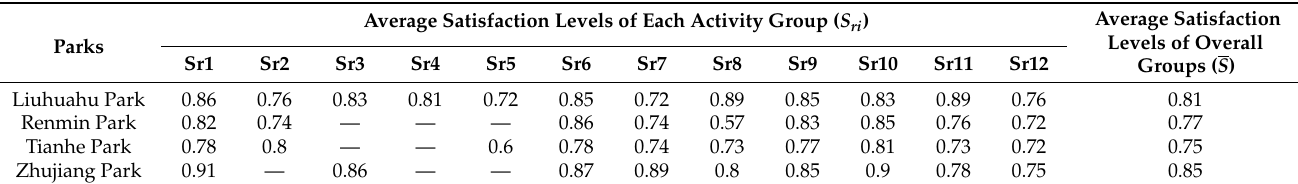
Average Satisfaction Levels of